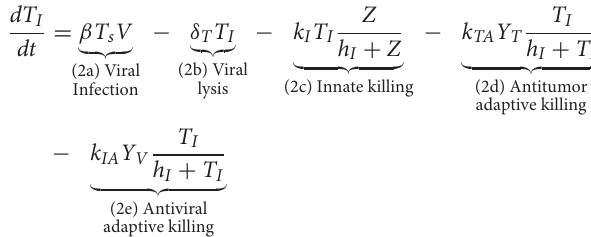
cell − 1 h − 1 from Mahasa et al. (2017), and we cells is k IA = 1 24